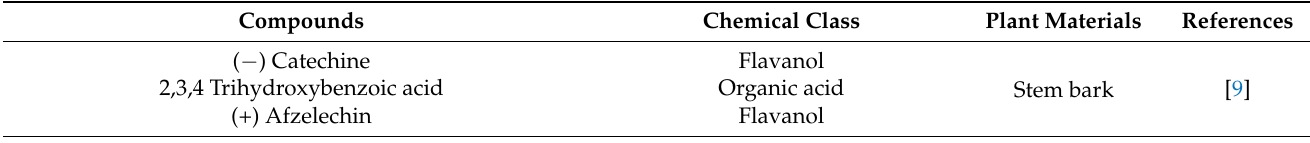
Table 1. Compound from Hovenia Dulcis isolated from 2005 to